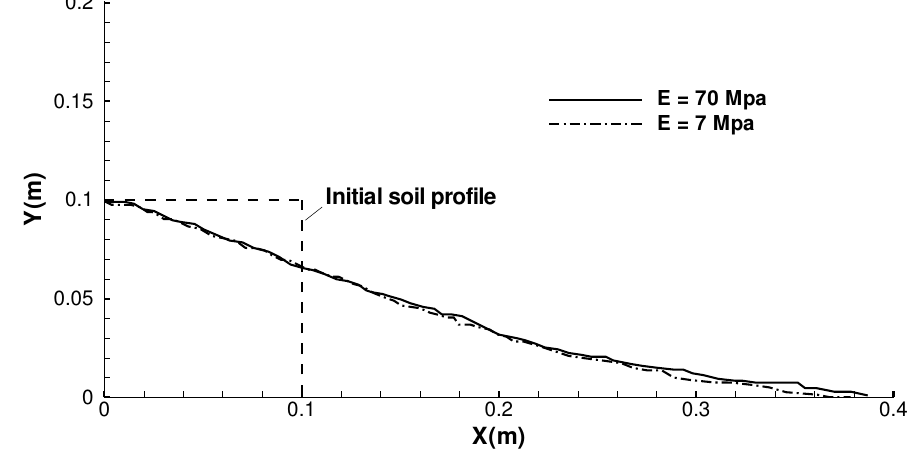
Figure 5. The final slope of a dry granular column collapse with different Young’s modulus E